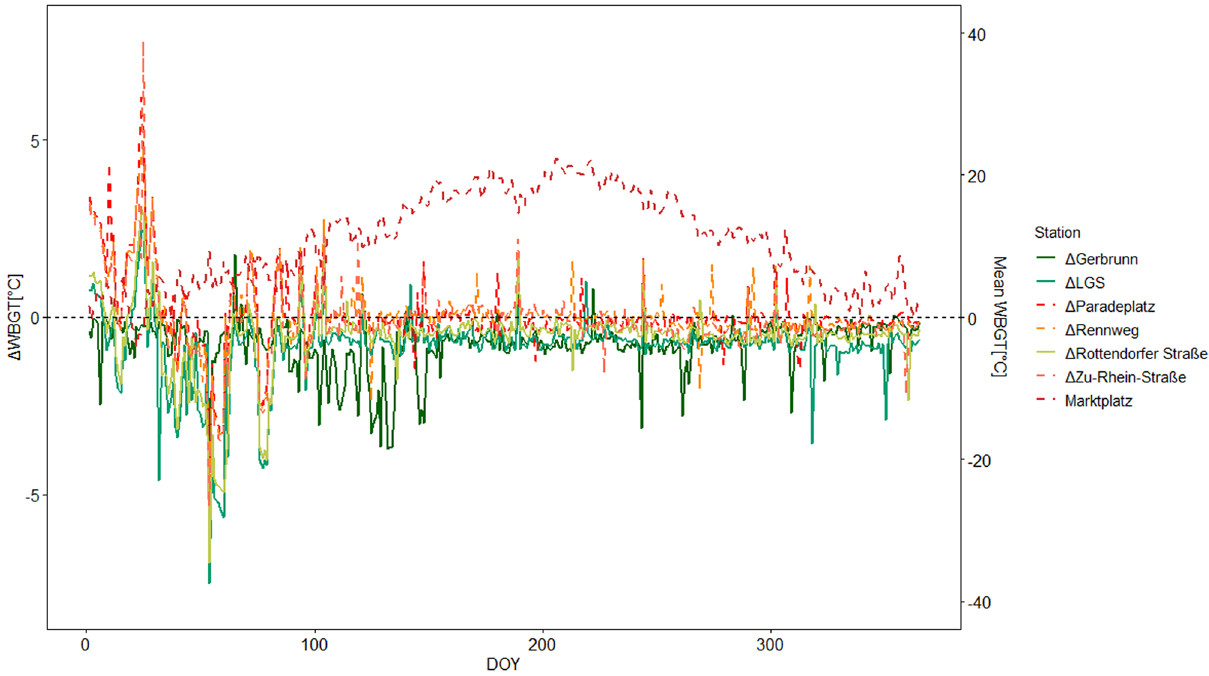
Figure 3. Three years average WBGT of Marktplatz and the average difference of WBGT in relation to Marktplatz (0-line as reference) at seven